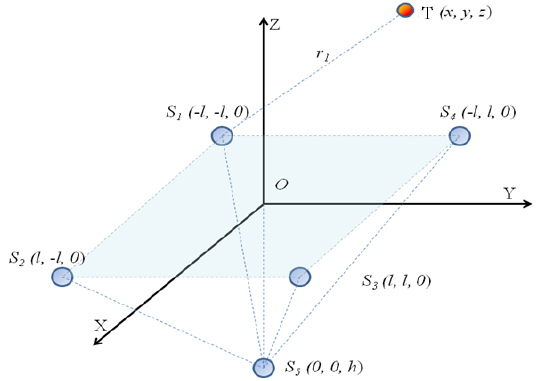
Figure 2. Planar electrode layout.